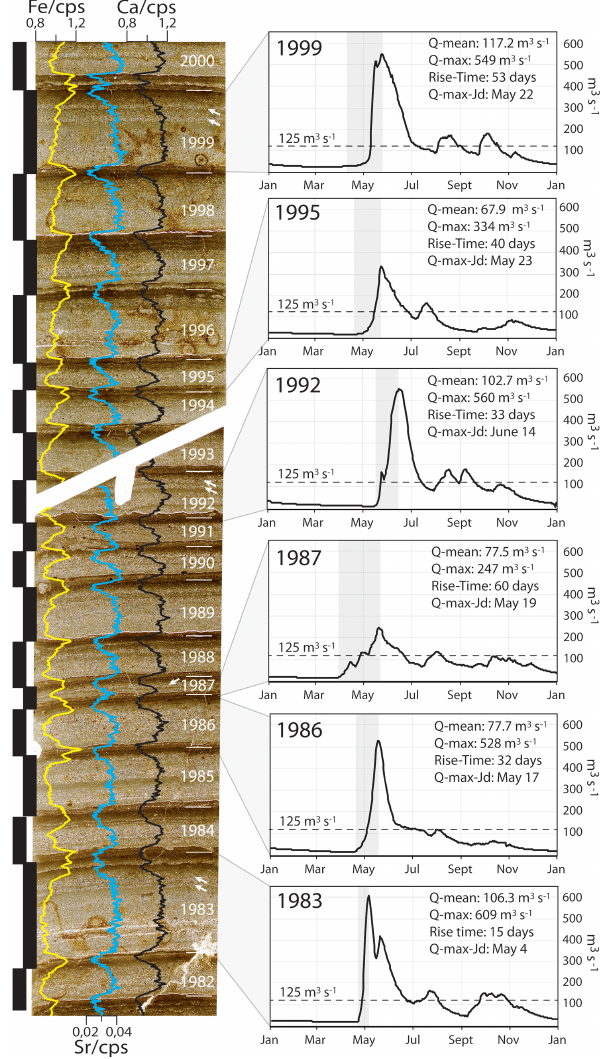
Figure 11. Qualitative comparison between NAS-1A varves from thin sections (delimited by the black bars) and the hydrographs of the Naskaupi River. Observed annual Q -mean and Q -max as well as the timing and rise time of the peak spring discharge are shown. Black dotted lines represent the discharge threshold of ∼ 125m 3 s − 1 . The years 1999, 1992, 1986 and 1983 represent strong spring floods associated with thick coarse varves. The years 1995 and 1987 represent low spring floods associated with thin varves. The years 1999, 1992, 1987 and 1983 represent coarser in- tercalated sub-layers in the upper part of the detrital layer linked with summer and autumn high-discharge events. The year 1986 rep- resents a strong spring flood with a low summer and autumn flow associated with a varve without substructure. Thin sections are over- lain by iron (Fe, yellow line), strontium (Sr, blue line) and calcium (Ca, black line) relative intensities. See Fig. 5 for thin sections lo-